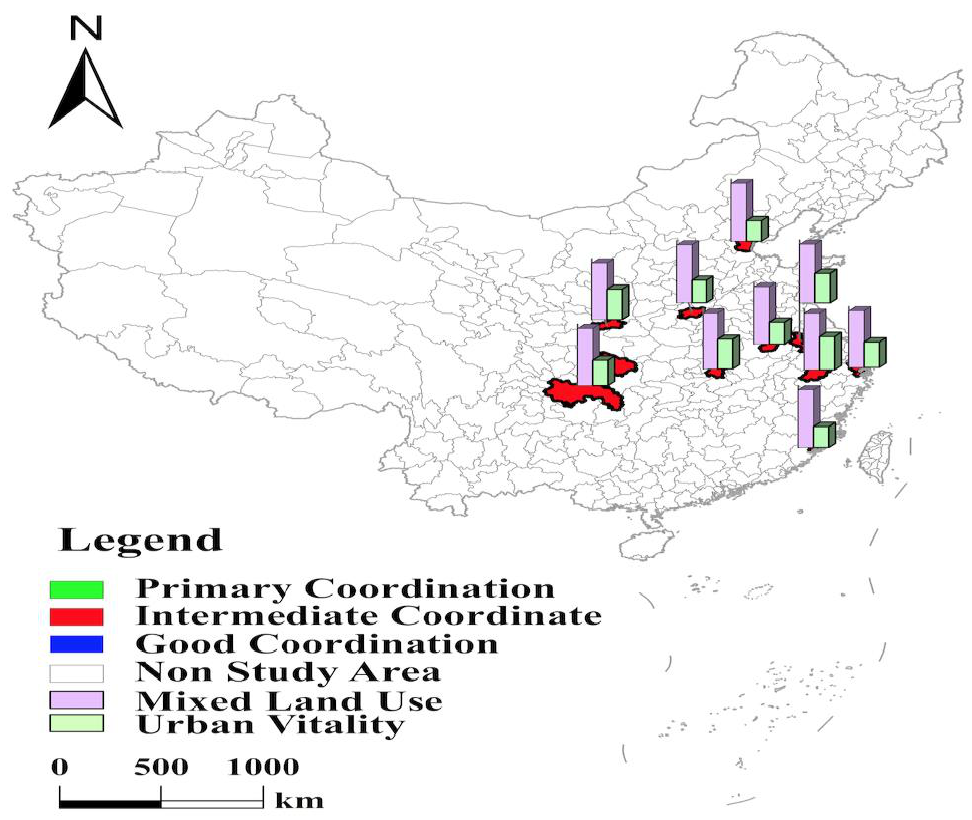
Figure 4. Levels of mixed land use, urban vitality, and coupling coordination in central part in 35 major cities.